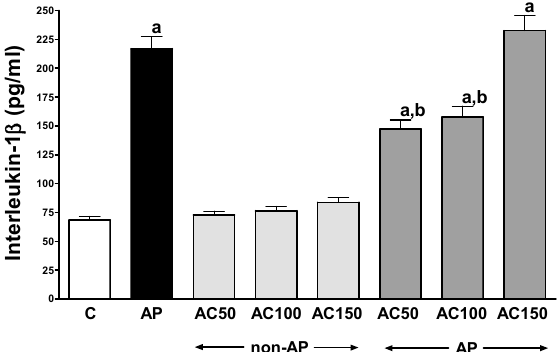
Figure 8. Impact of pretreatment with acenocoumarol on serum concentration of interleukin-1 β in rats with or without cerulein-induced pancreatitis. Key: C = control; AP = cerulein-induced acute pancreatitis; non-AP = groups without induction of acute pancreatitis; AC = acenocoumarol; 50 = 50 µg/kg/day; 100 = 100 µg/kg/day; 150 = 150 µg/kg/day. Mean ± SEM. n = 10 in each group of rats. a p < 0.05 compared to control; b p < 0.05 compared to AP alone.